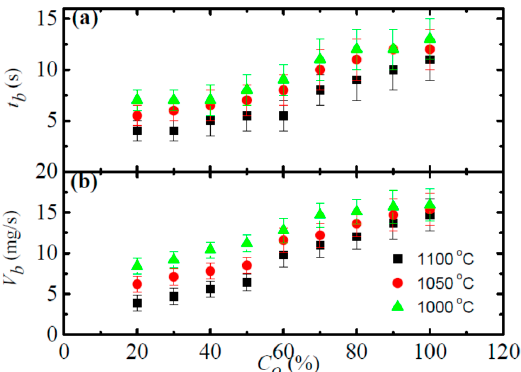
Figure 6. ( a ) The burning duration ( t b ) as a function of the oxygen partial pressure ( C o ); and ( b ) the corresponding burning velocity ( v b ) as a function of C o . The results are averaged over five burning